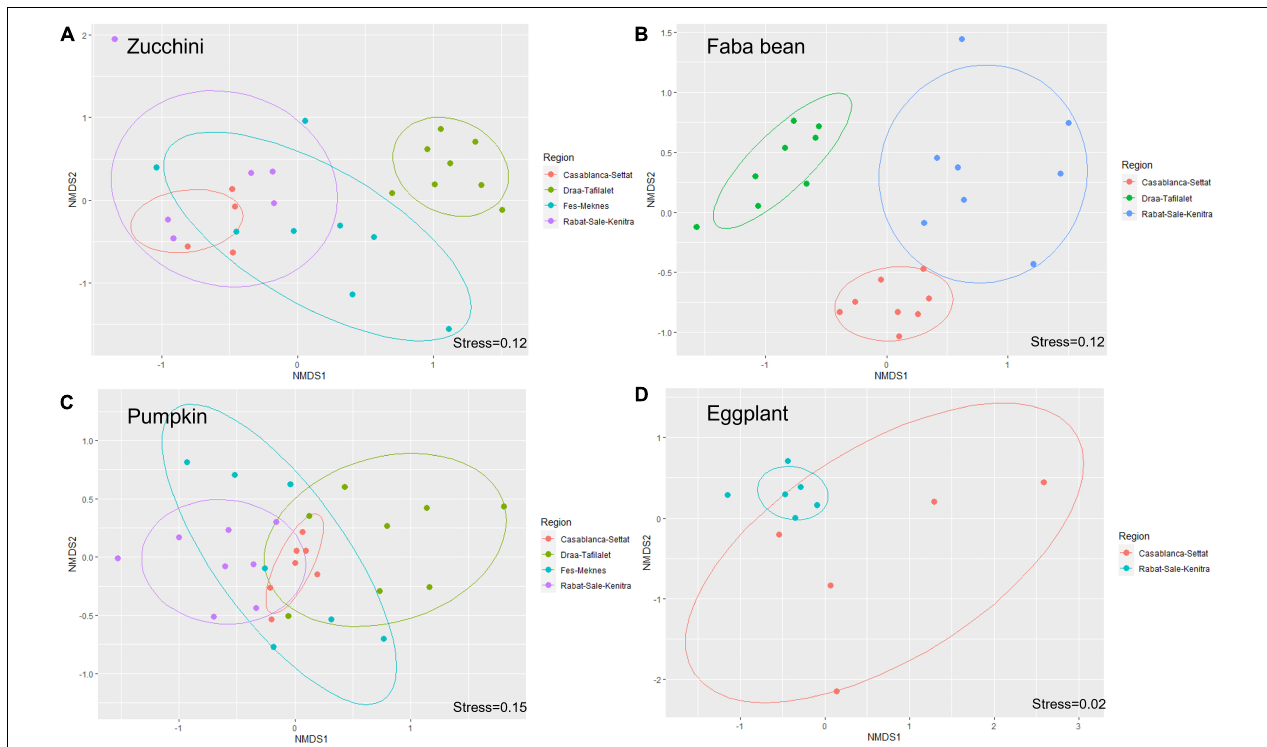
FIGURE 5 | Non-metric multidimensional scaling (NMDS) ordination showing differences in bee community composition among regions for zucchini (A) , faba bean (B) , pumpkin (C) , and eggplant (D) .